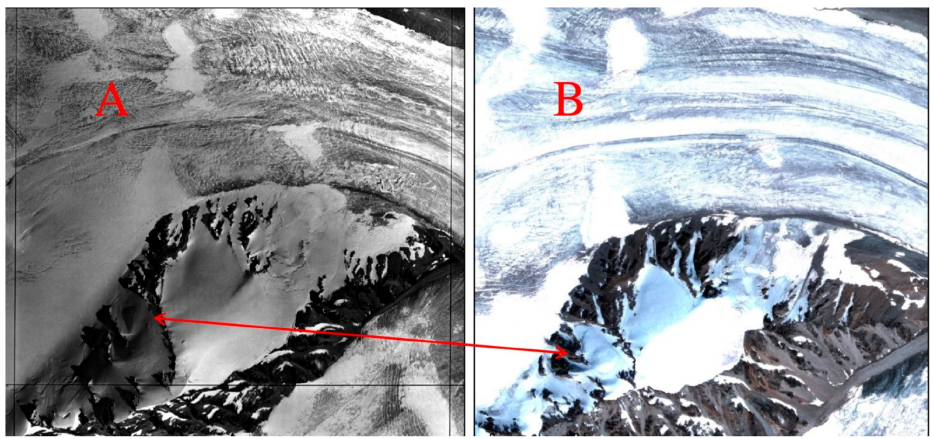
Figure 11. Degradation in the accumulation zone of the Potanin glacier. ( A ) aerial image, 1962; ( B ) Geoeye-1 image, 24 July 2010. 7. Attachment of preglacial snow patches that survive through the entire ablation season to the glacial termini. This is typical for glaciers with a steep lobe with high snow accumulation in the wind shade under it. This process takes place in the snowiest years and causes lower ablation on the glacial front and some insufficient increase in glacial length. Such events took place, for example, in 2010, 2011, and 2013 at the fronts of Left Mugur and West Mugur glaciers (Mongun-Taiga). 8. Attachment of preglacial icings to the glacial termini. In the 1992–1993 balance year, at the Mongun-Taiga massif, the East Mugur Glacier became 18 m and the Seliverstova Glacier 17 m longer.